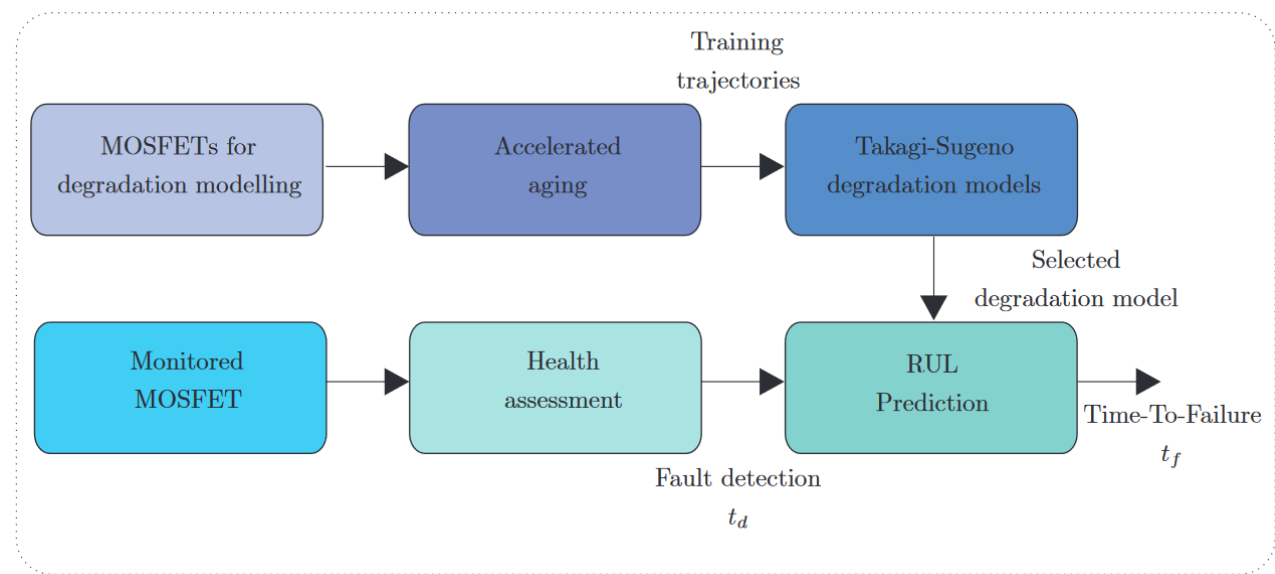
Figure 4. Methodology of RUL prediction with Takagi-Sugeno (T-S) degradation model.